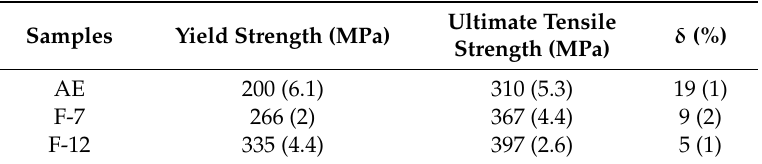
Table 2. Mechanical properties of the